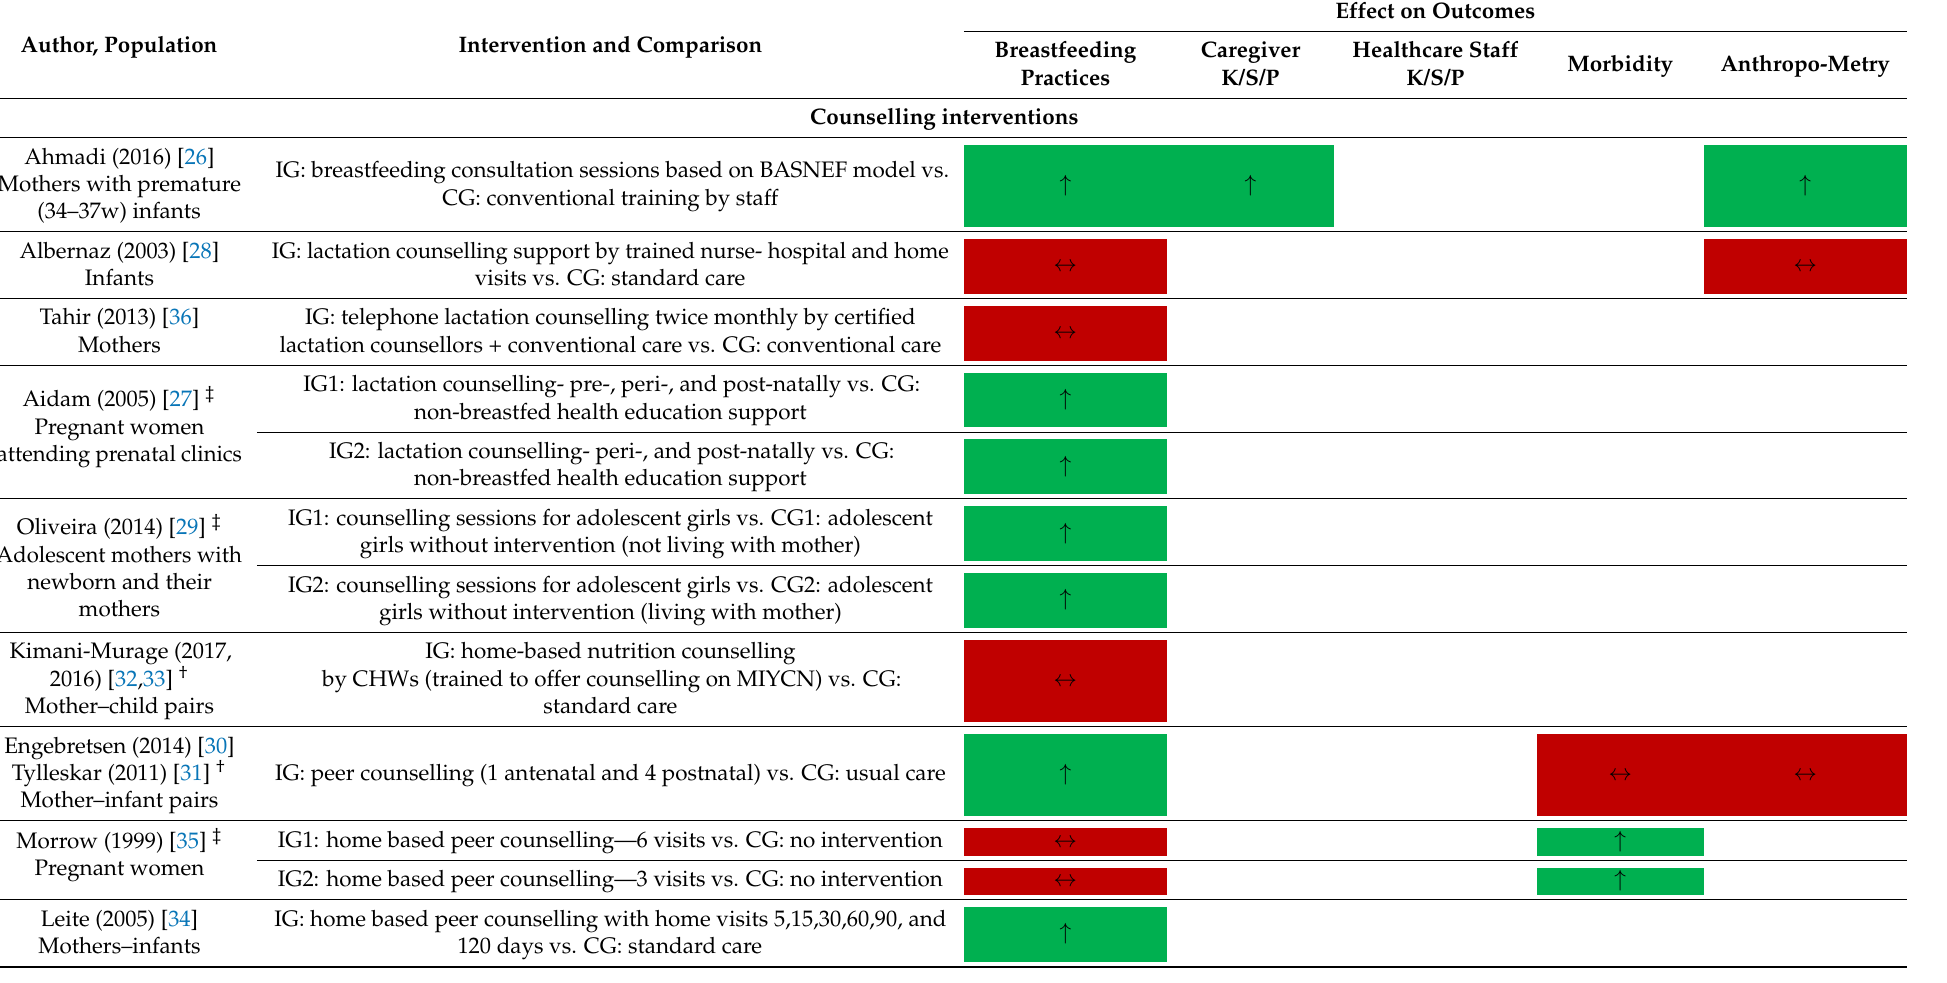
Table 2. Summary of effect of breastfeeding interventions on breastfeeding practices, knowledge/skills/practices of caregivers and healthcare staff, morbidity, and anthropometry outcomes.